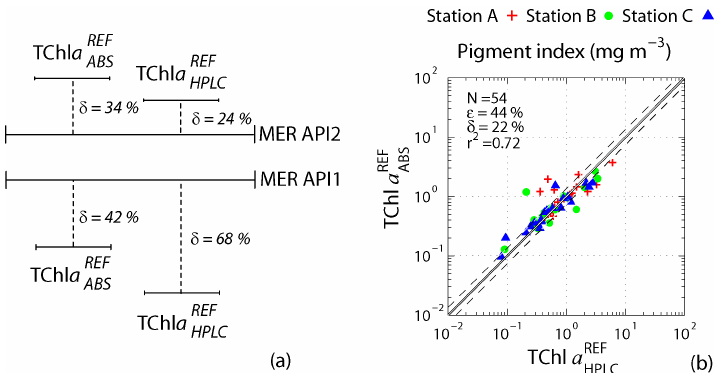
Figure 2. (a) Schematic diagram showing, respectively, underestimation and overestimation of MERIS Algal Pigment Indices 1 and 2, relative to TChl a , estimated through the absorption coefficient at 442nm (TChl a REF plot of the TChl a REF vs. TChl a REF ABS HPLC